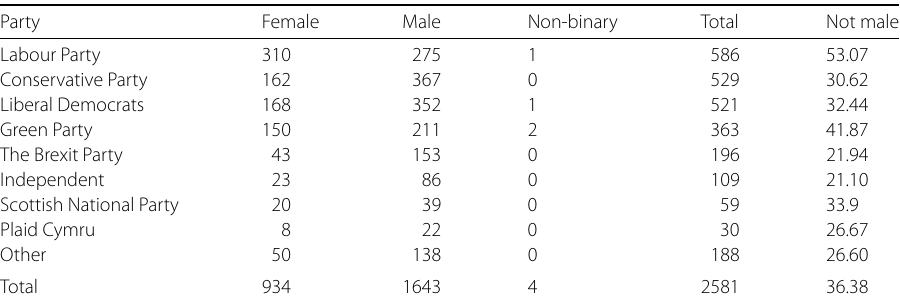
Table 2 Number of tweets, retweets and replies by candidates are given, alongside replies received, of which abusive, and the percentage thereof. The first line shows findings for the six week election campaign period. The second line contrasts this with the corresponding period for the 2017 UK general election